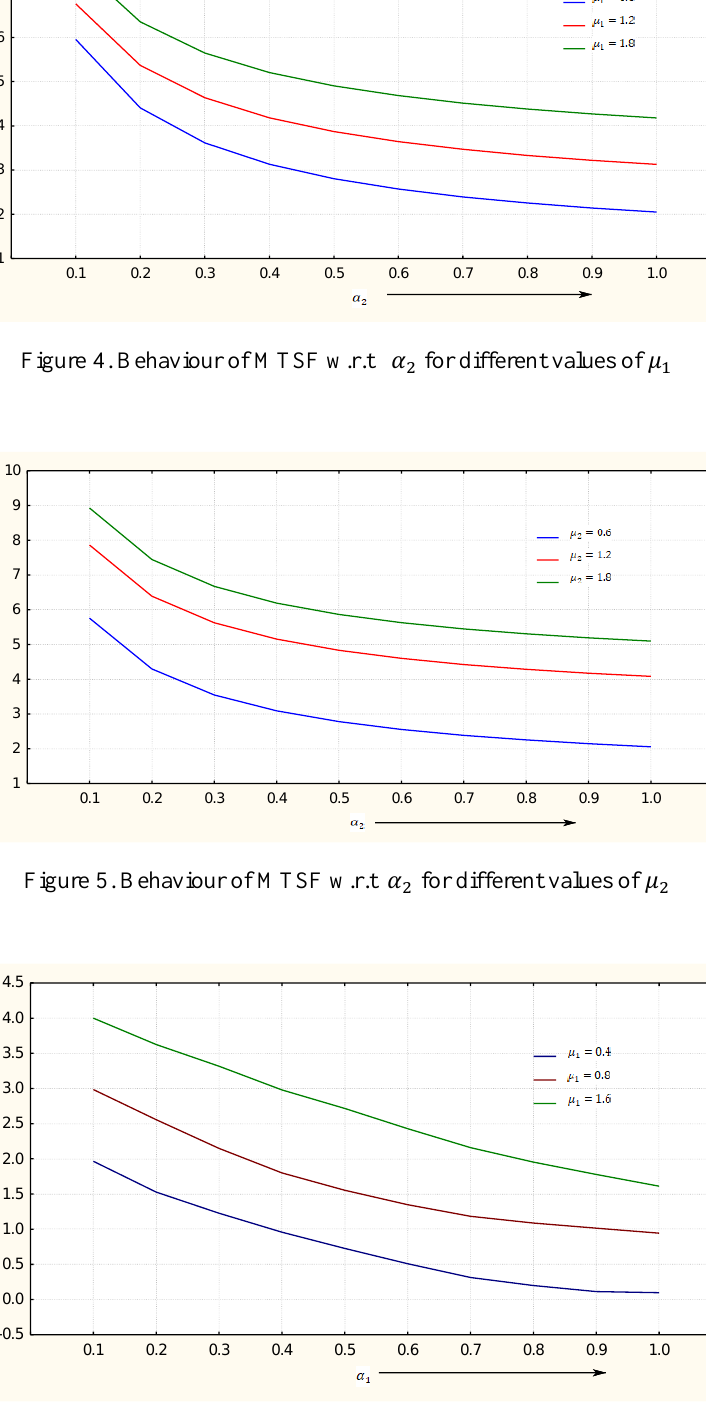
for different values of 𝜇 1